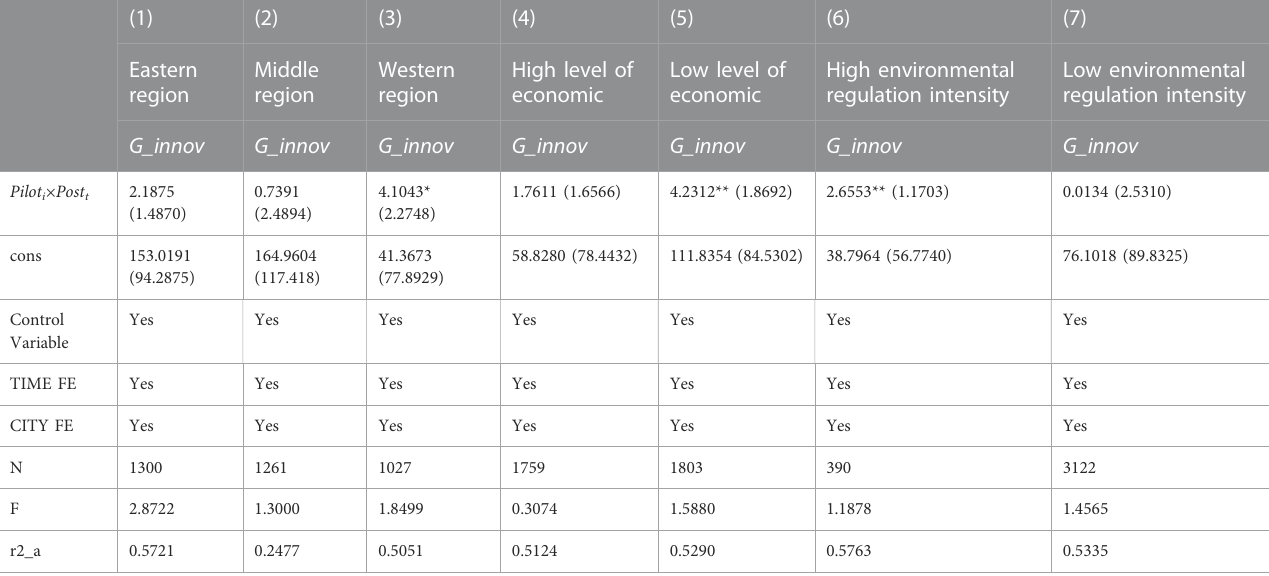
TABLE 4 Results of heterogeneity